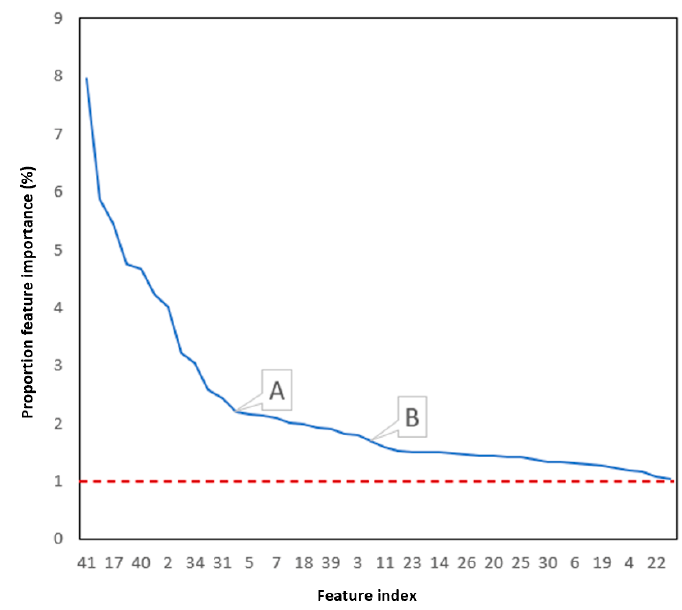
Figure 10. Proportion of importance of original feature space.